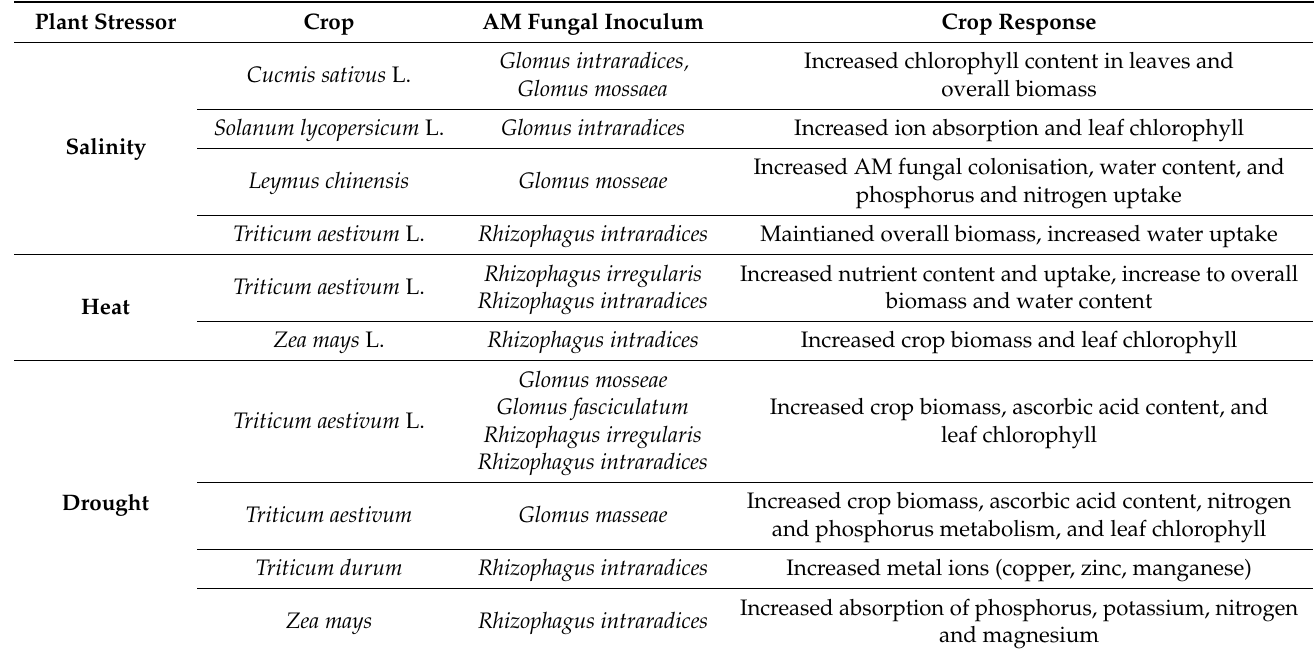
Table 3. Arbuscular mycorrhizal (AM) inoculum to established crop to mitigate abiotic plant stressors (salinity, heat and drought), with measured resultant effects. An update to [154,157–168]. Plant Stressor Crop